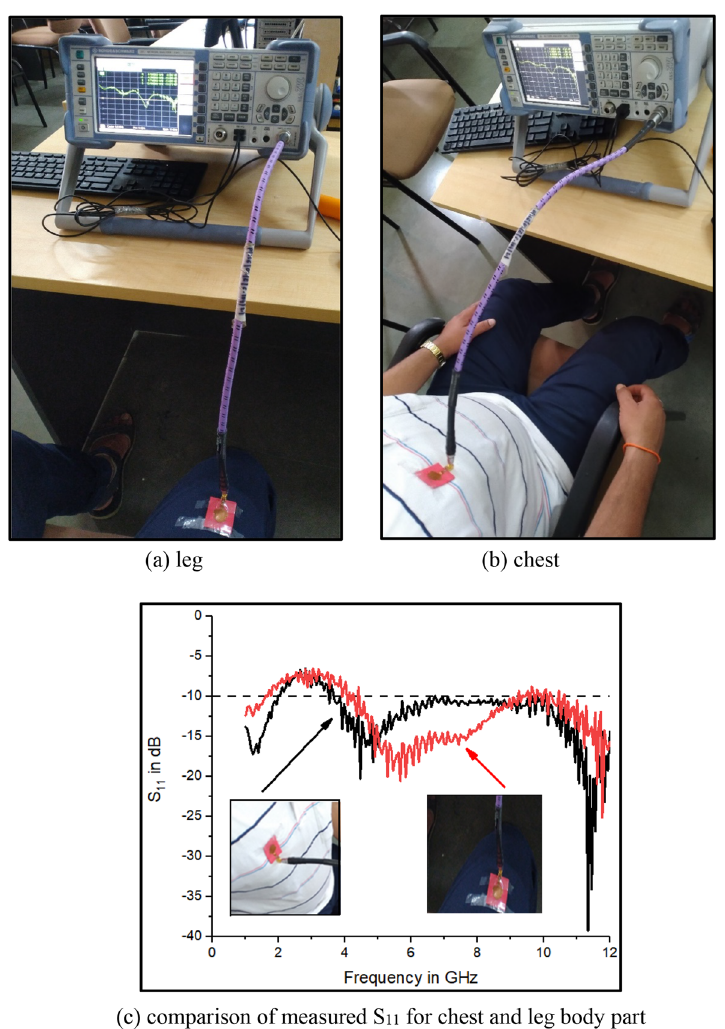
Fig. 11 On-body measurements. The proposed antenna is tested for on-body performance by mounting it on the chest and leg ( a , b ) of the body part. The results obtained are compared and depicted in ( c ). When a human body comes into close vicinity of antenna, the performance of antenna in terms of return loss ( S 11 ) and bandwidth is affected. As presented in ( c ), the response of the proposed antenna is maintained for the flat body part as the antenna is mounted on the chest. At the same time, when the antenna is tested over a curved portion of the leg, the response is affected severely in terms of bandwidth with a shift in frequency below 10 −